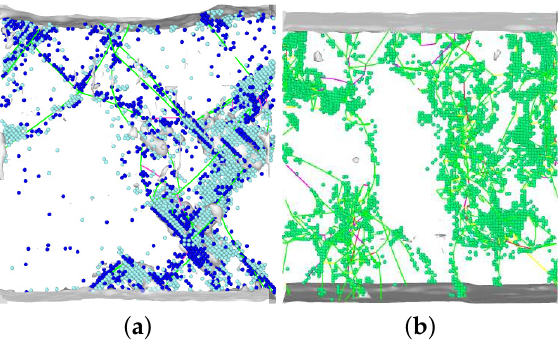
Figure 6. Nucleation of the ( a ) austenitic and ( b ) martensitic phase in the corresponding transformations. Sample ( a ) with a dislocation density of ρ = 4.5 × 10 12 cm − 2 corresponds to Figure 5b at the start of the austenitic transformation process; sample ( b ) with a dislocation density of ρ = 10.34 × 10 12 cm − 2 corresponds to Figure 8c at the start of the martensitic transformation process. The colored lines denote the dislocation type in the original phase, the green (blue) atoms, the nucleating bcc (close-packed (cp))-phase as in Figure